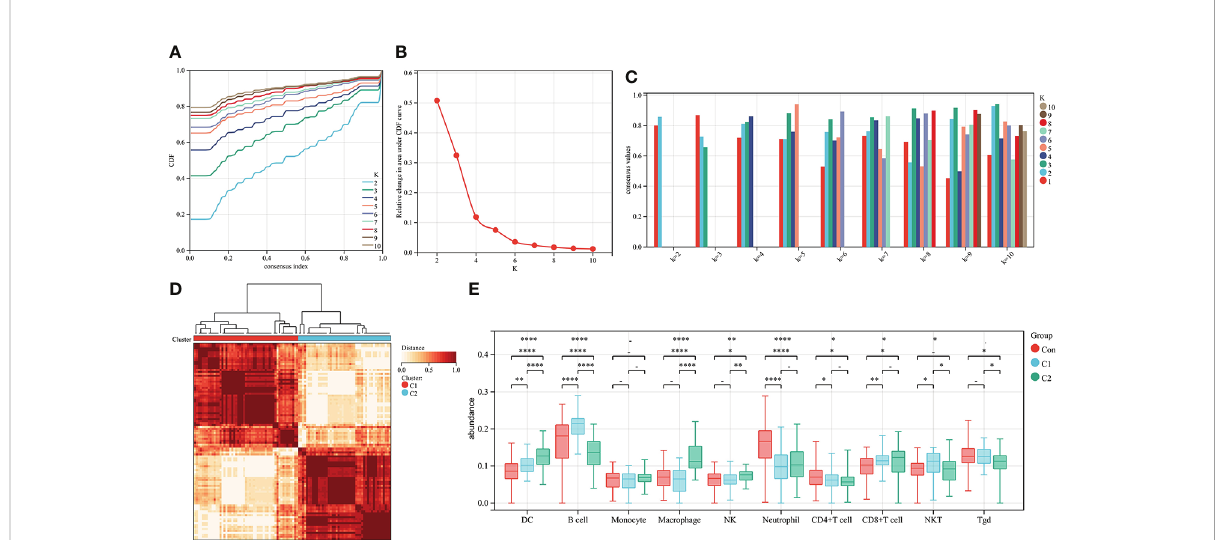
FIGURE 3 Cluster analysis of 100 IgAN samples in data1 based on the abundance of immune cells. (A) The CDF curve of different K-values; the CDF delta has the slowest downward trend when K-value = 2. (B) The relative change in area under CDF curve; as the K-value increased, the area under the CDF curve increases gradually. (C) The bar graph of the consistency within the clusters; the number of clusters with the highest average consistency within the group was K-value = 2. (D) The heat map of clusters; there were 53 IgAN samples in cluster 1, whereas there were 47 IgAN samples in cluster 2. (E) The differences in abundance of 10 types of layer1 immune cells between controls, cluster 1, and cluster 2. *P ≤ 0.05, **P ≤ 0.01, ****P ≤